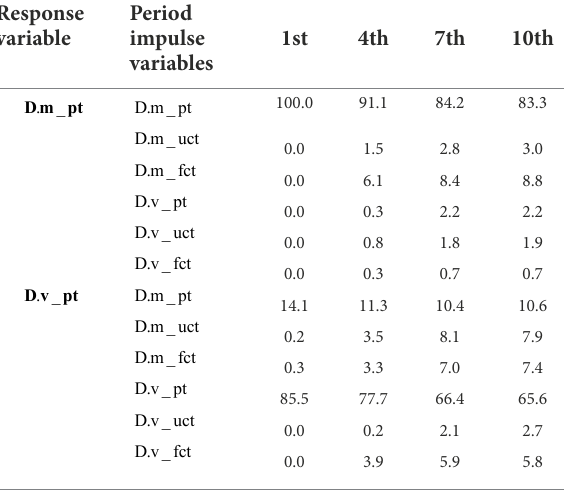
TABLE 5 The source of contribution ( . _ Dm pt or . _ Dv pt as response variable).